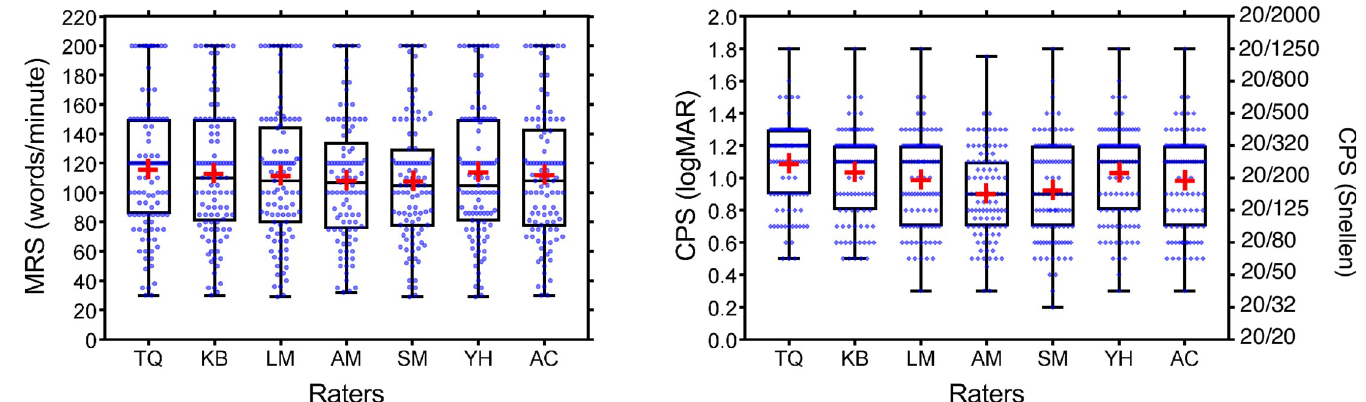
Fig 3. Box and whisker plots of estimated MRS (left) and CPS (right), grouped by raters and sorted in ascending order of expertise level (from 0 to 4). Boxes represent the 25th to 75th percentiles and whiskers range from min to max values. Medians (lines) and means (red cross) are also represented.